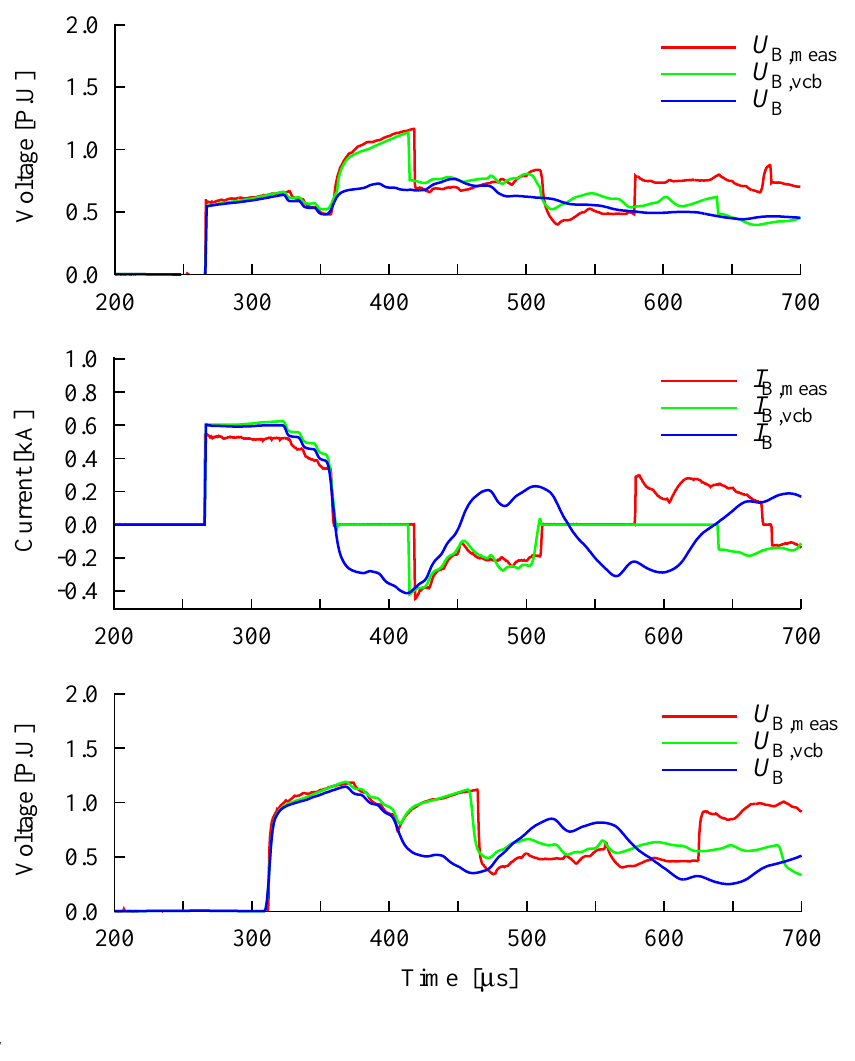
Figure 7. Comparison of measurement data and PSCAD simulation results for phase B voltages and currents at the platform (top and middle plot, respectively) and voltages at A9, when the built-in switch and the VCB model are